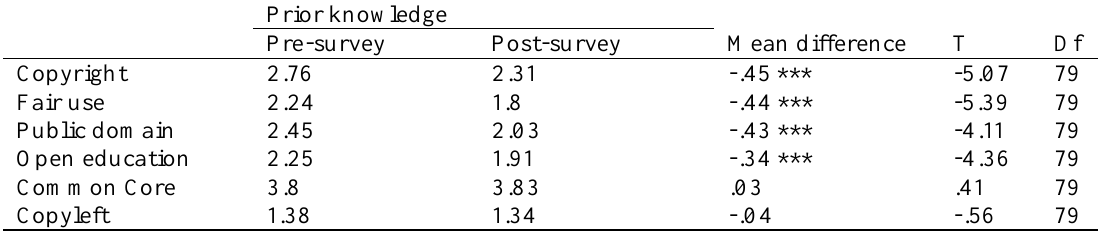
Comparison of Pre-Survey and Post-Survey Prior Knowledge Ratings Prior